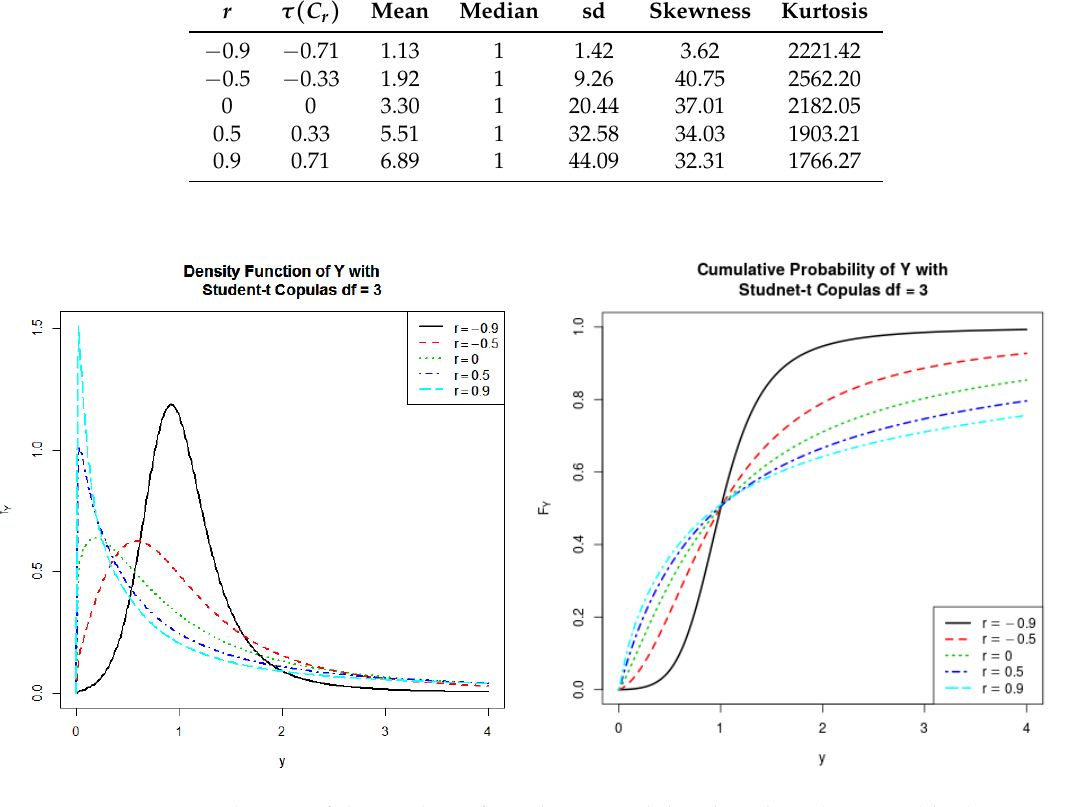
Figure 2. PDFs and CDFs of the product of two log-normal distributed random variables having Student t-Copulas ν =